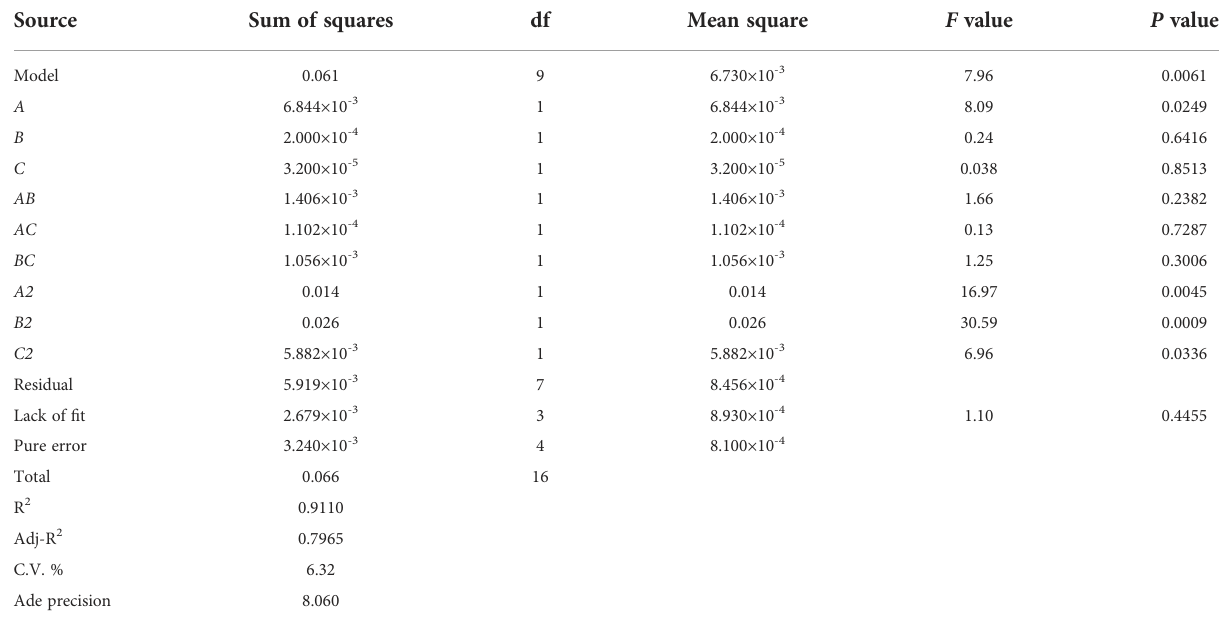
TABLE 1 Variance analysis results of the regression